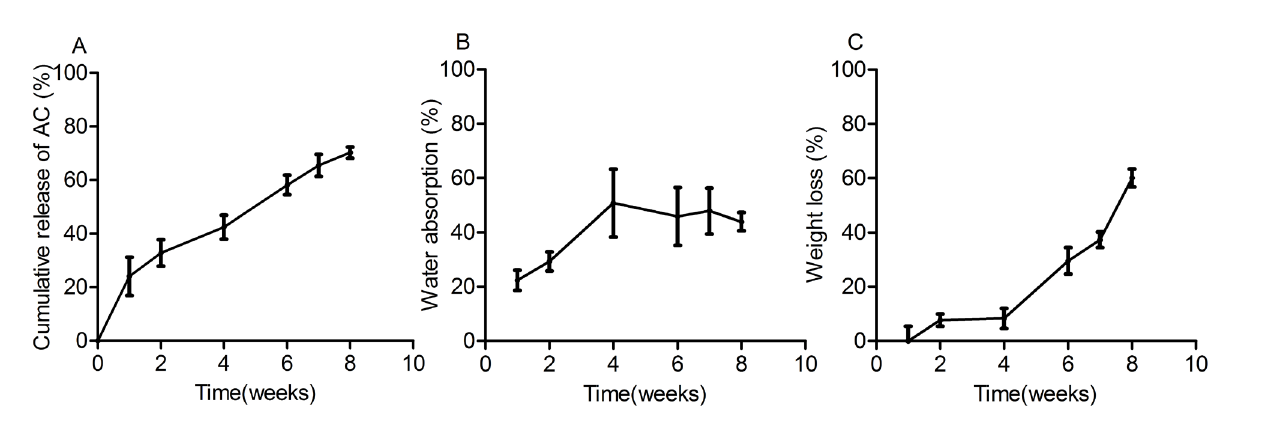
FIGURE 6 - In vitro release profile of CA from the polymeric device: (A) cumulative release of CA; (B) water absorption (C) weight